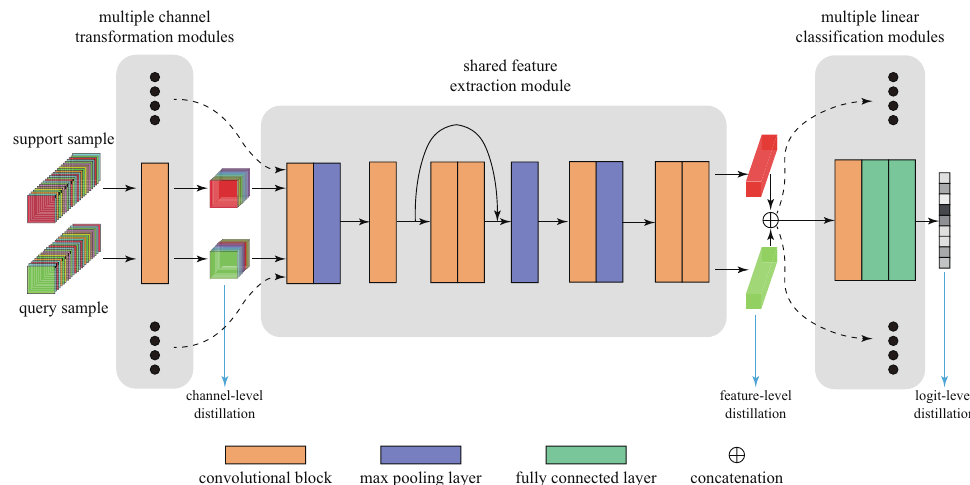
Figure 4. Schematic of the designed multi-task model for general-purpose representation learning (actually a detailed expansion of the bottom half of Figure 2). The designed model can receive multiple-source HSIs simultaneously and perform knowledge distillation and label prediction on multiple-source domains; therefore, it conforms to the paradigm of multi-task